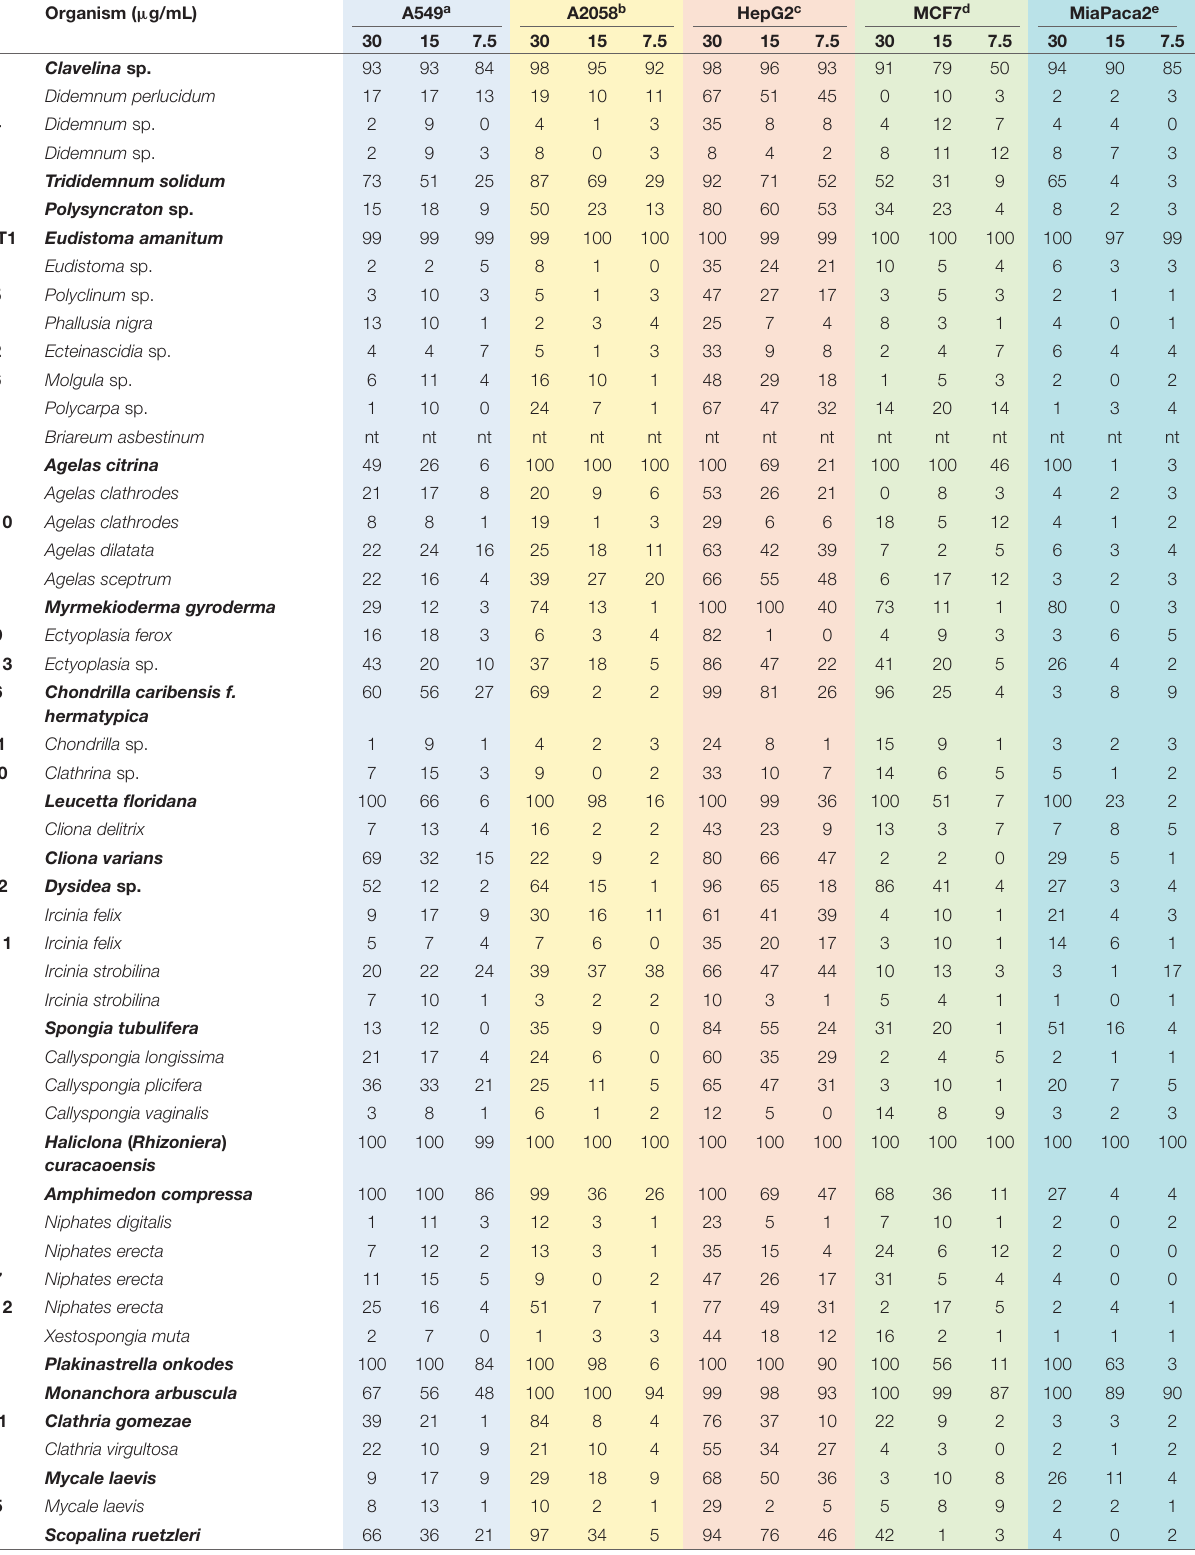
TABLE 3 | Antiproliferative activity in % of inhibition of organic extracts at different concentrations (in µ g/mL) of marine organisms from Yucatan Peninsula. Code Organism ( µ